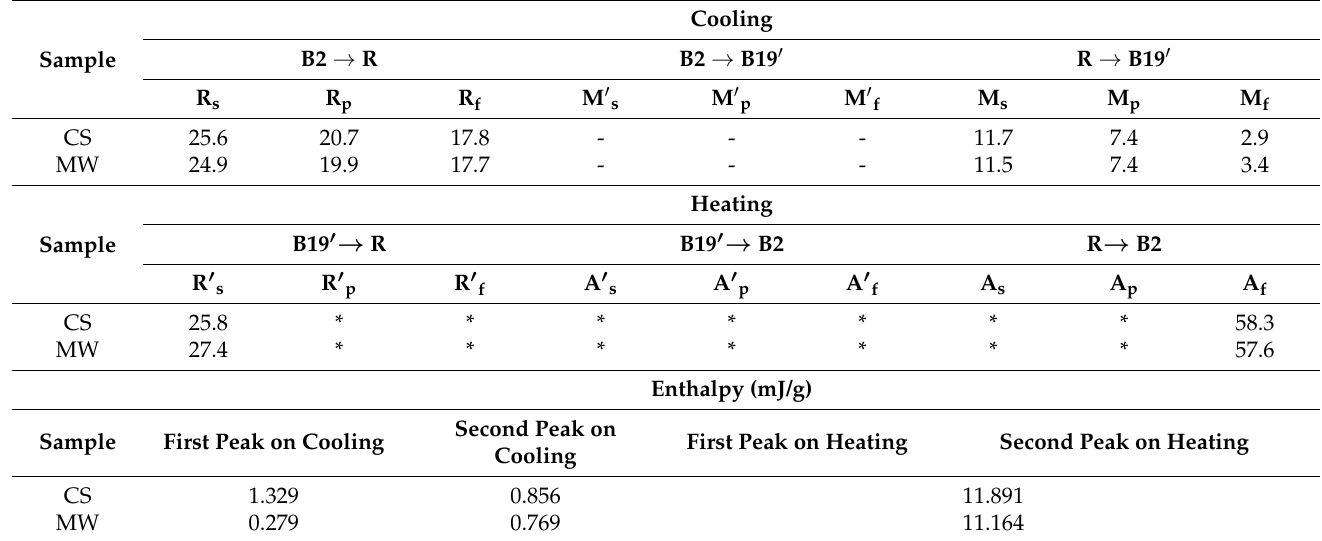
Table 2. Phase transformation temperatures in degrees Celsius and enthalpy of MW and CS samples. “-” Not detected; “*”